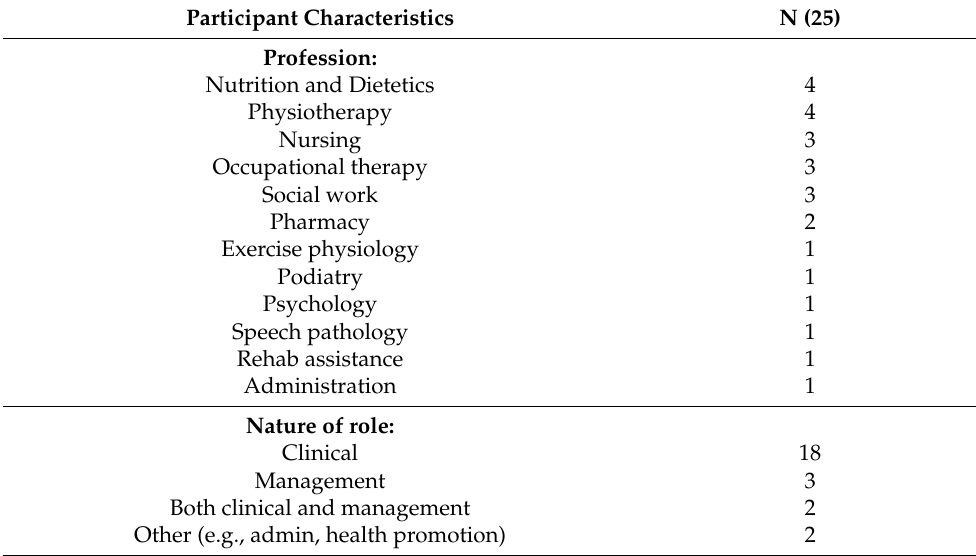
Table 2. Participant